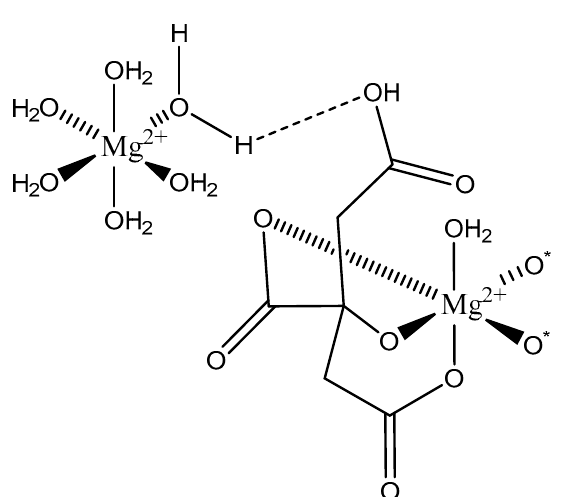
Figure 23. Illustrated structure of citric acid.